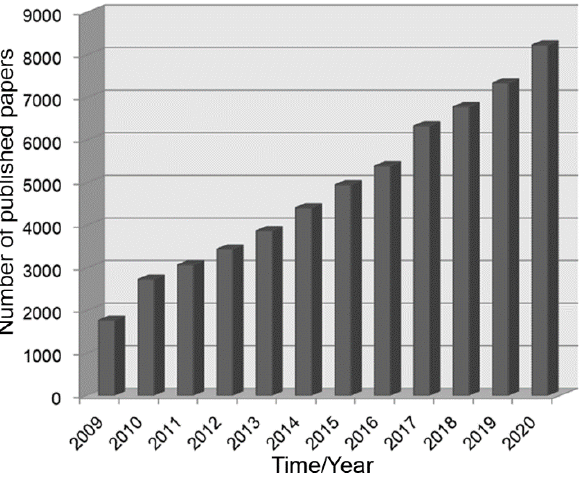
Figure 1. The number of the published papers on nanostructured metal oxide heterojunctions for high-performance gas sensors during 2009–2020 as obtained from the Web of Science. The words “nanostructured metal oxide heterojunctions” or “high-performance gas sensors” were keyed into the “topic” search box.